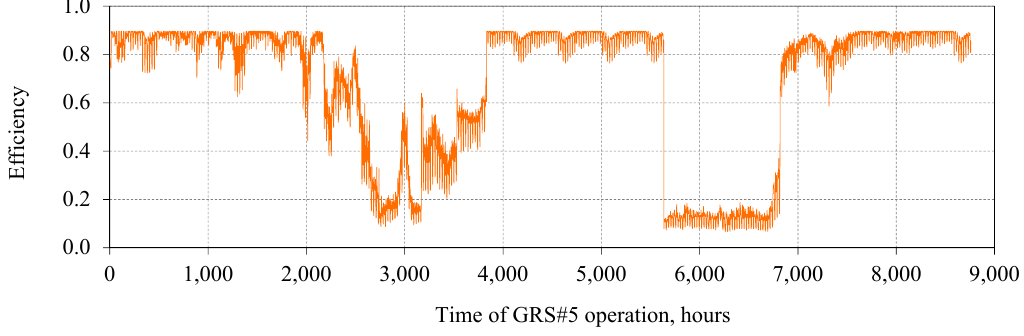
Figure 14. Generated electrical energy and heat demand at GRS #5 over a period of one year.